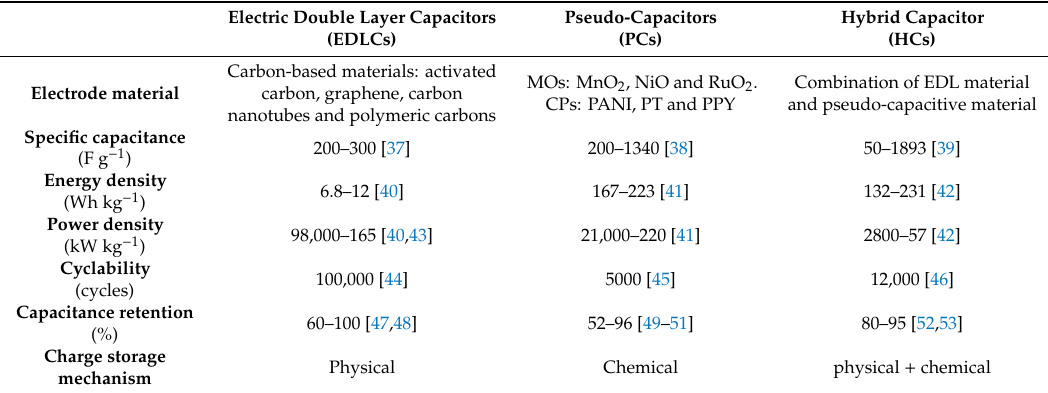
Table 1. Material selection and performance characteristics of ELDCs, PCs and